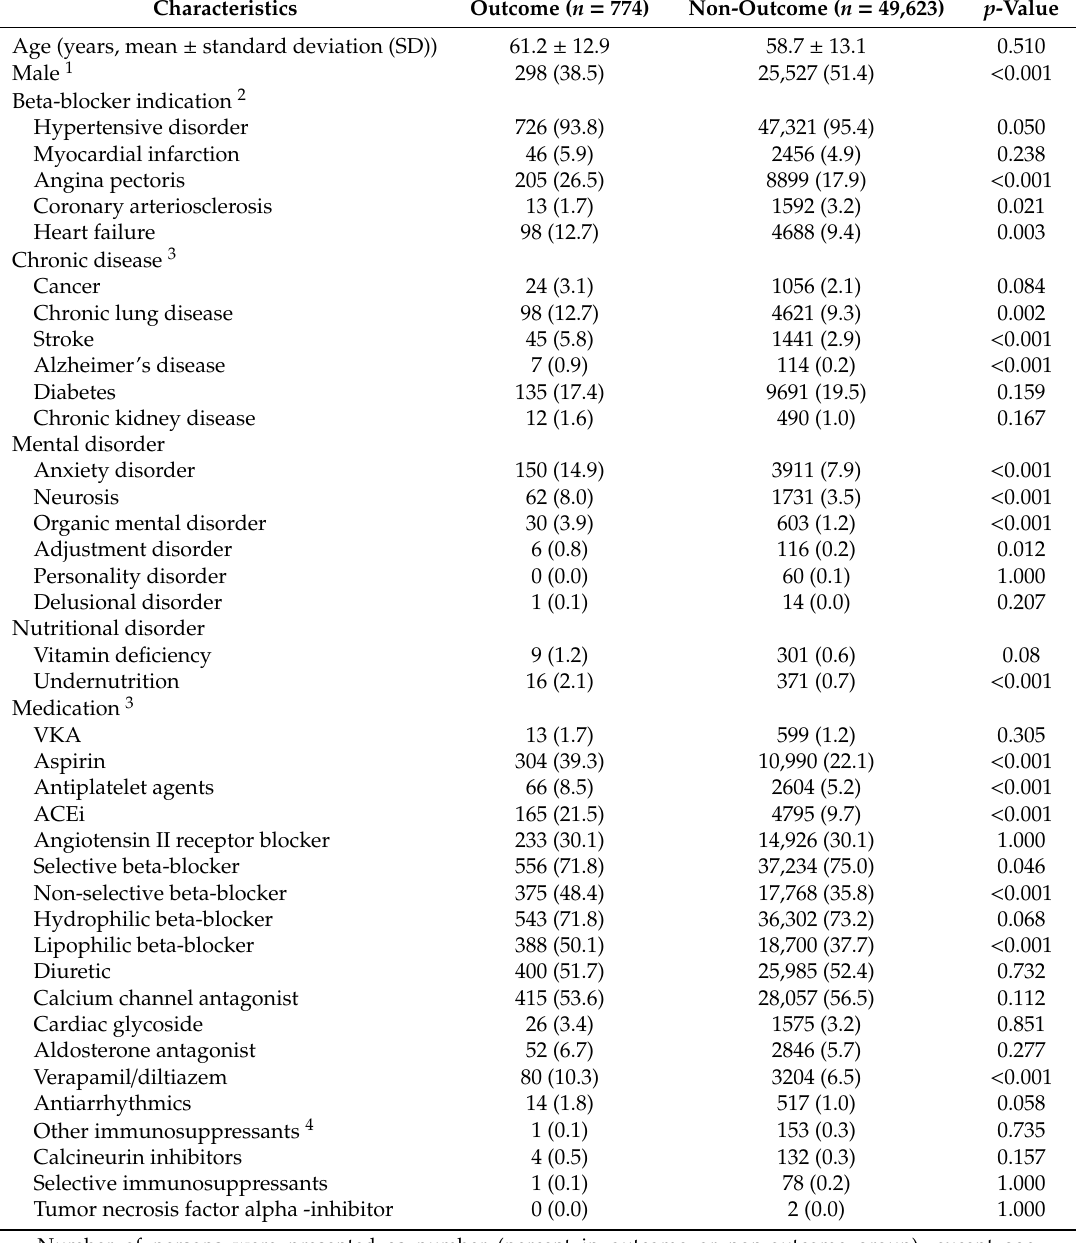
Table 1. Basic characteristics of study population with outcome, and